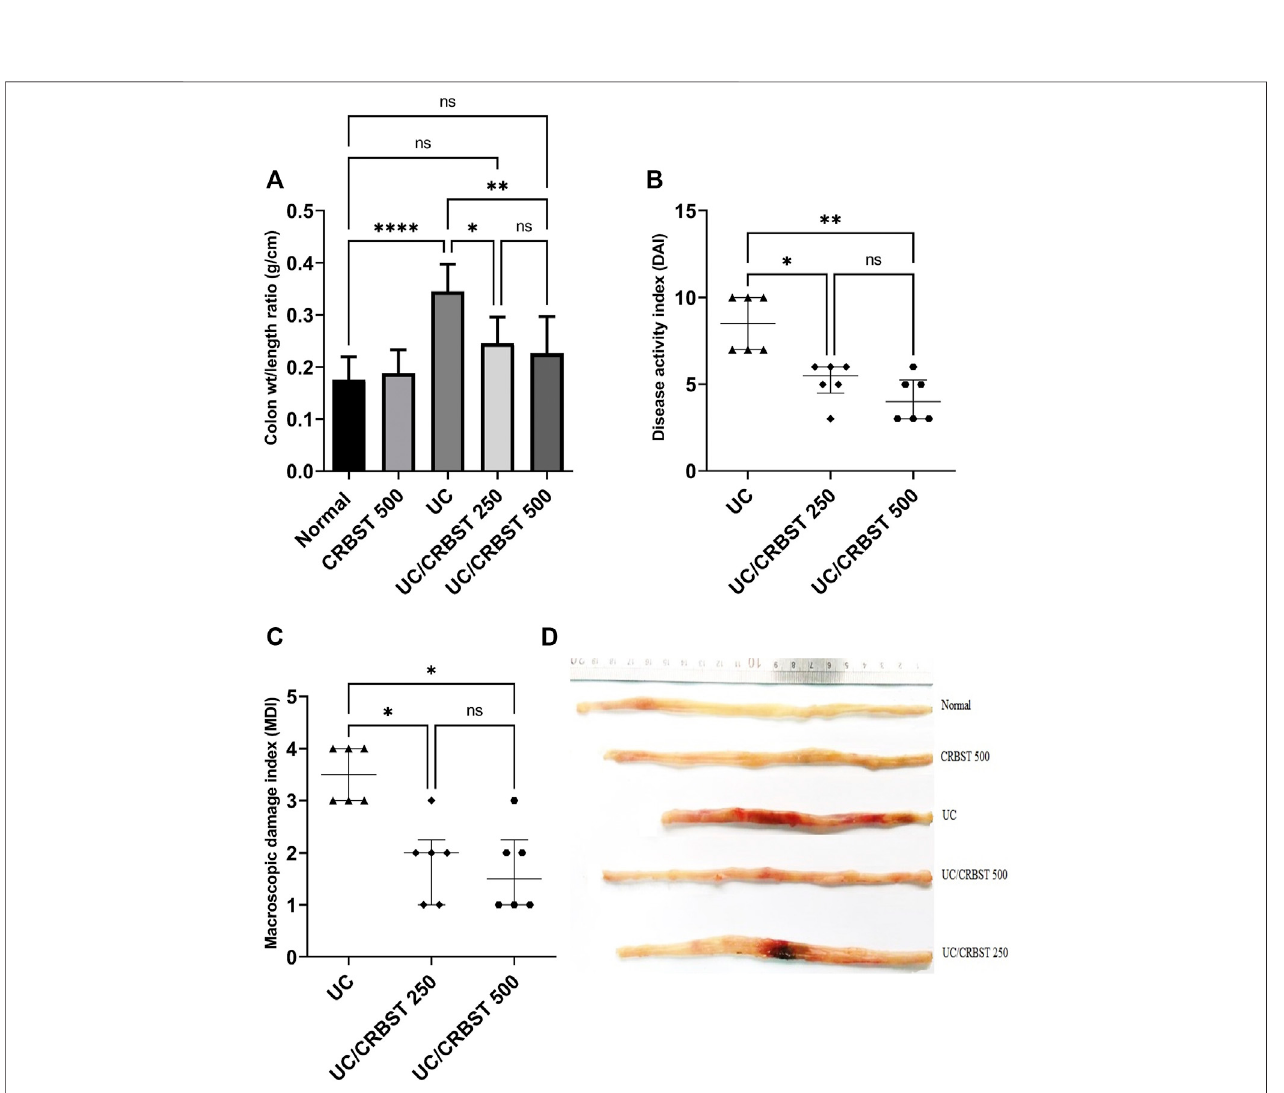
FIGURE1| EffectofCRBST 250and 500 mg/kgoncolonweight/lengthratio (A) ;DAI (B) ;MDI (C) ;and thecolonpictures (D) inratswithAA-induced UC. Results in fi gure (A) areshownasthemean±SDandin fi gure (B,C) areshownasthemedian±interquartilerange(n=6). p p < 0.05, pp p < 0.01, pppp p < 0.0001.Normal,normal control rats administered the vehicle; CRBST 500, normal rats administered carbocisteine (500 mg/kg); UC, AA-induced UC rats administered the vehicle; UC/CRBST 250, AA-induced UC rats treated with carbocisteine (250 mg/kg); UC/CRBST 500, AA-induced UC rats treated with carbocisteine (500 mg/kg).